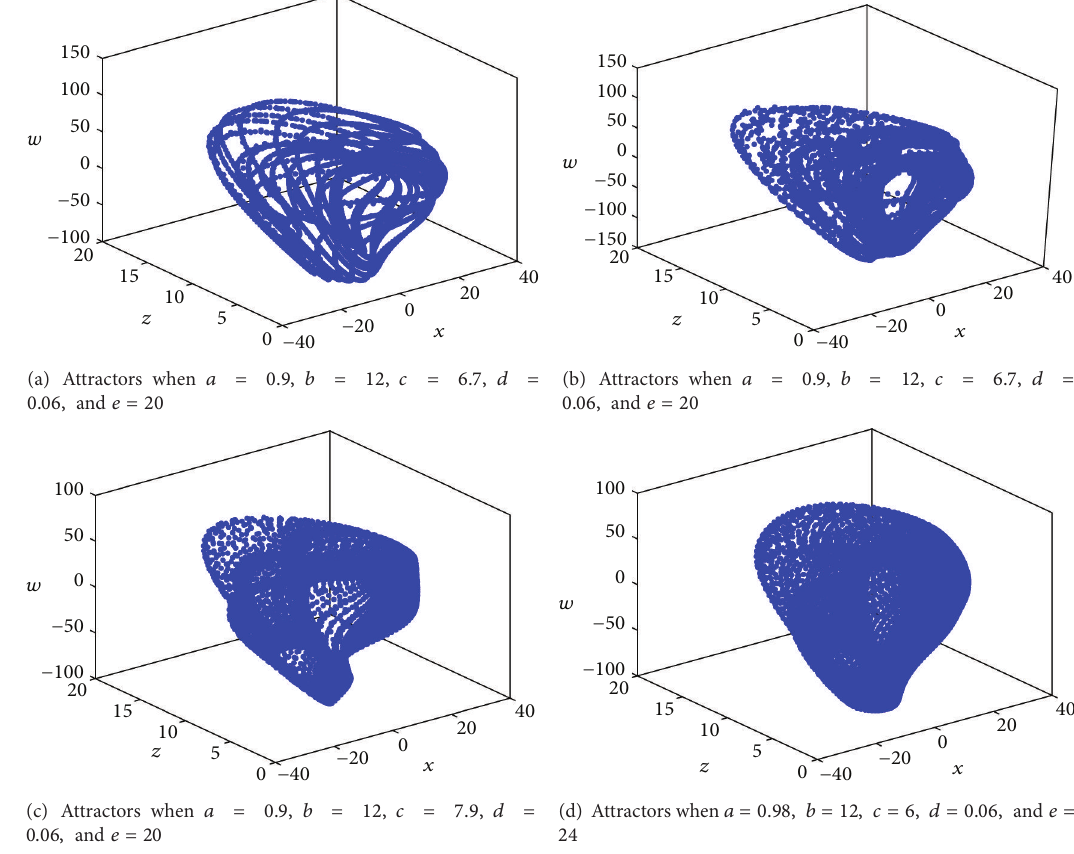
Figure 3: Attractors when 𝑥 = 11.28 , 𝑦 = −11.21 , 𝑧 = −9 , and 𝑤 = 20.49 with different